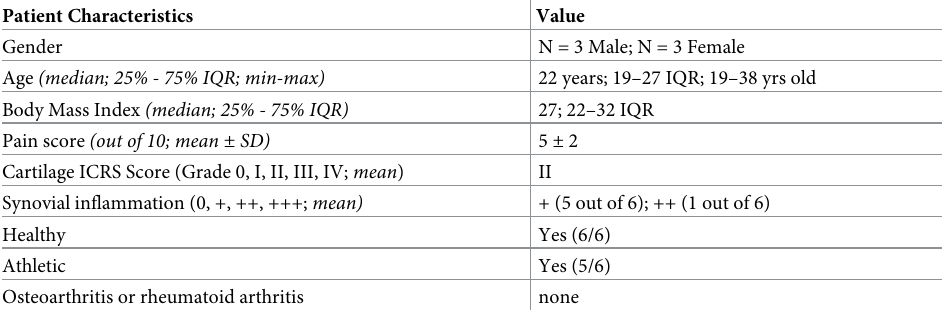
Table 1. Human synovial biopsy donor characteristics (N =